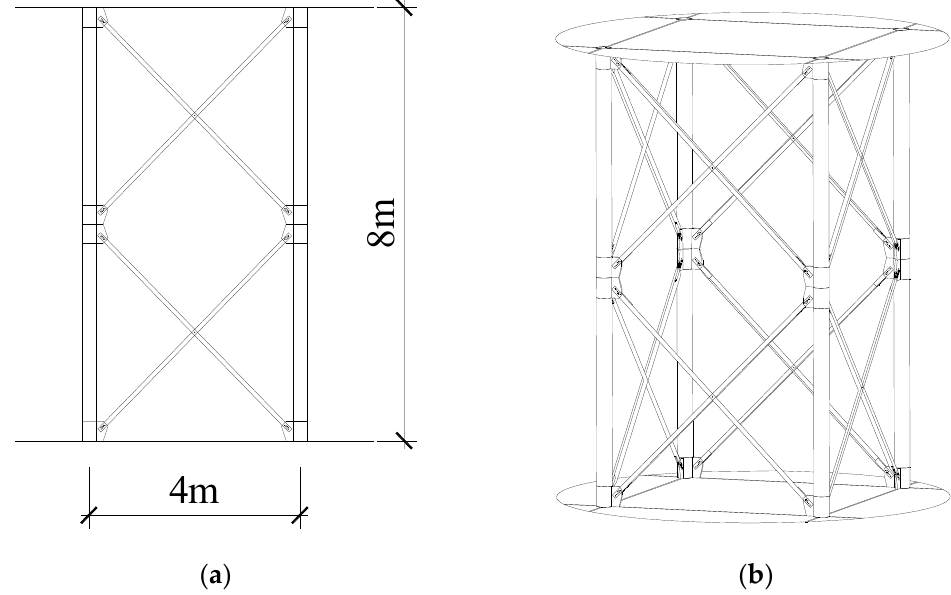
Figure 14. ( a ) Geometric dimensions of geometric model of quadrilateral tower; ( b ) three-dimensional drawing of geometric model of quadrilateral tower.